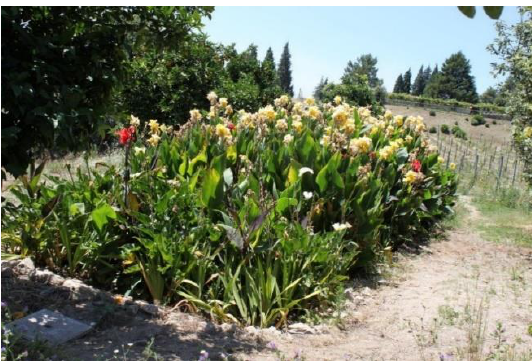
Figure 1. Constructed wetland (CW) treating wastewater from a tourism house (Portugal).